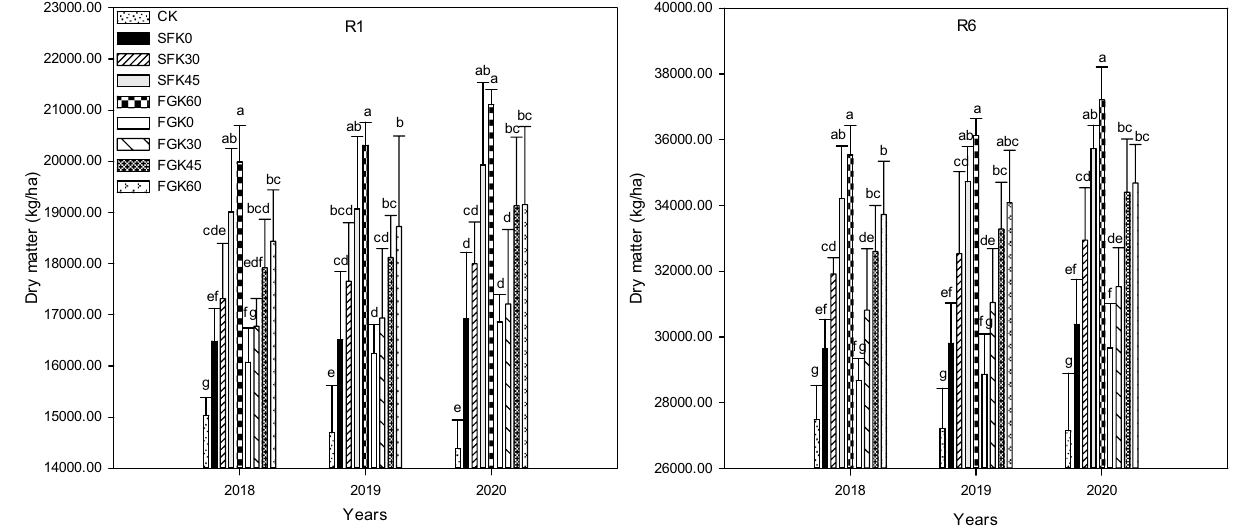
Figure 2. Effects of straw return methods and potassium fertilization levels on maize dry matter. Values followed by different letters in the same year indicated indicate statistical significance at α = 0.05 under different treatments. The same